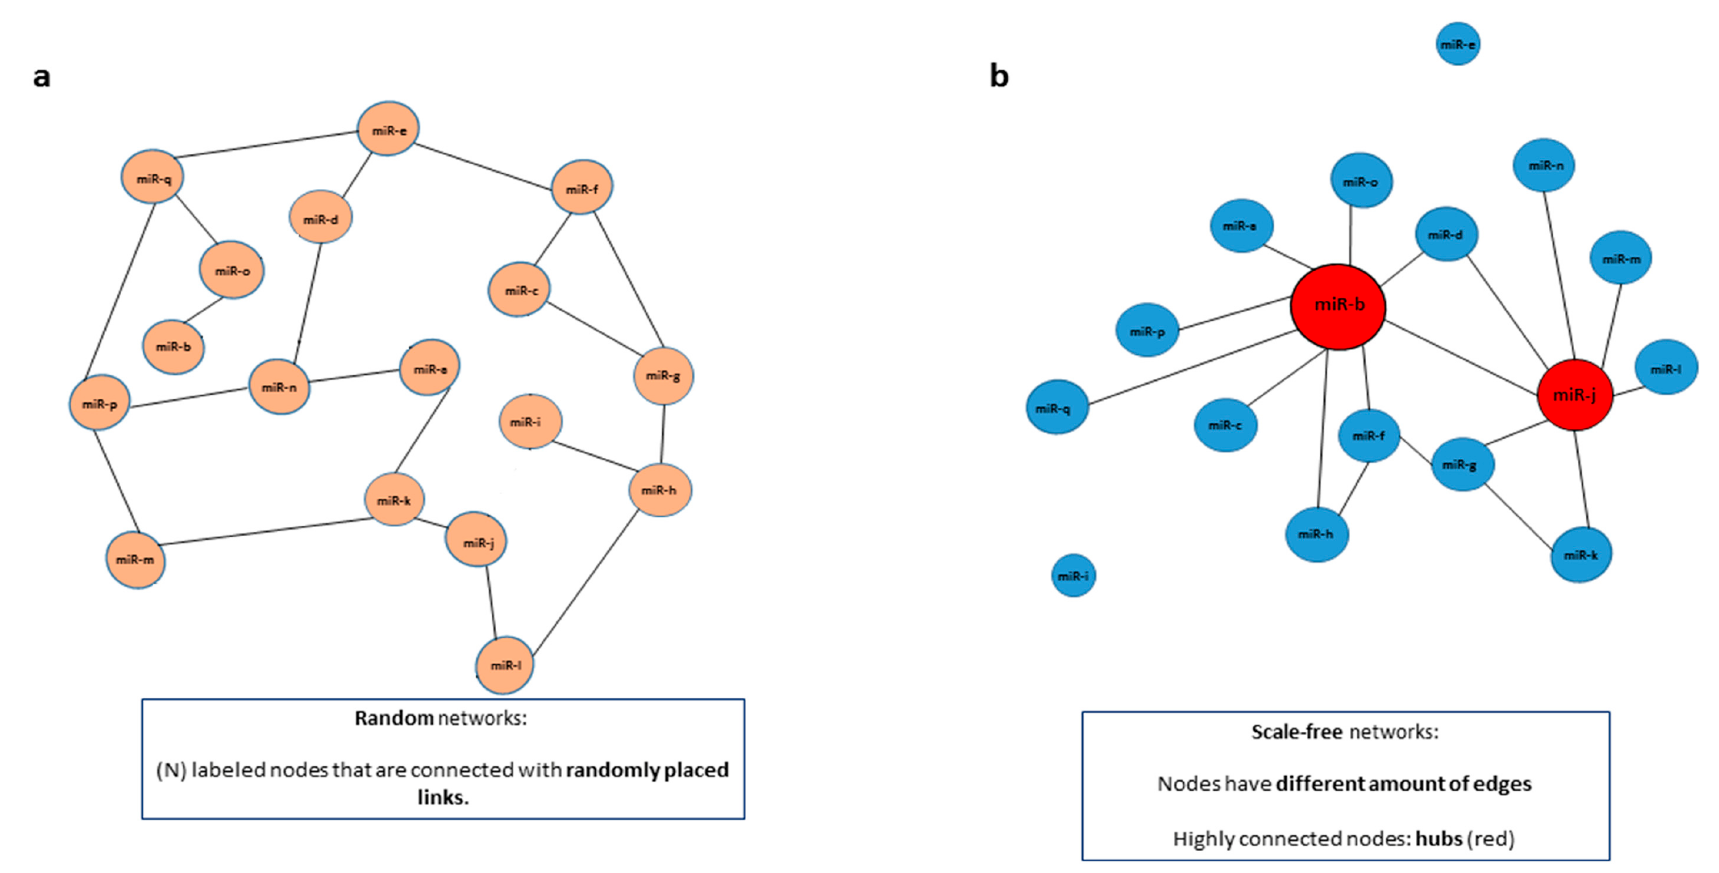
Figure 2. Networks can be characterized as random or scale-free. Networks can be classified as random or scale-free, depending on how the edges are shared among the nodes. ( a ) In random networks, (N) labeled nodes are connected with randomly distributed links (edges). ( b ) In scale-free networks, on the other hand, nodes have a different amount of edges and are not distributed randomly. In a scale-free miRNA network some miRNAs (in red) have more connections than others (in blue). Highly connected nodes, in this case represented by miRNAs in red, are termed hubs.